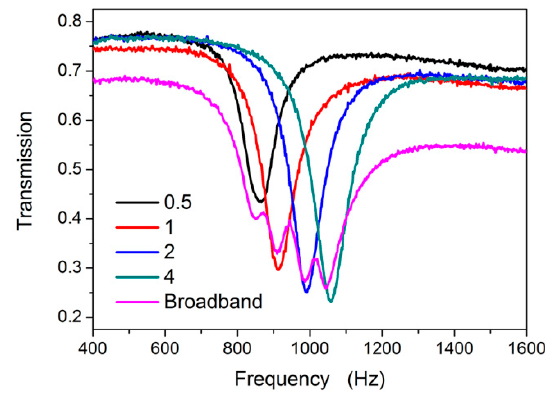
Figure 7. The transmission of broadband AMM.